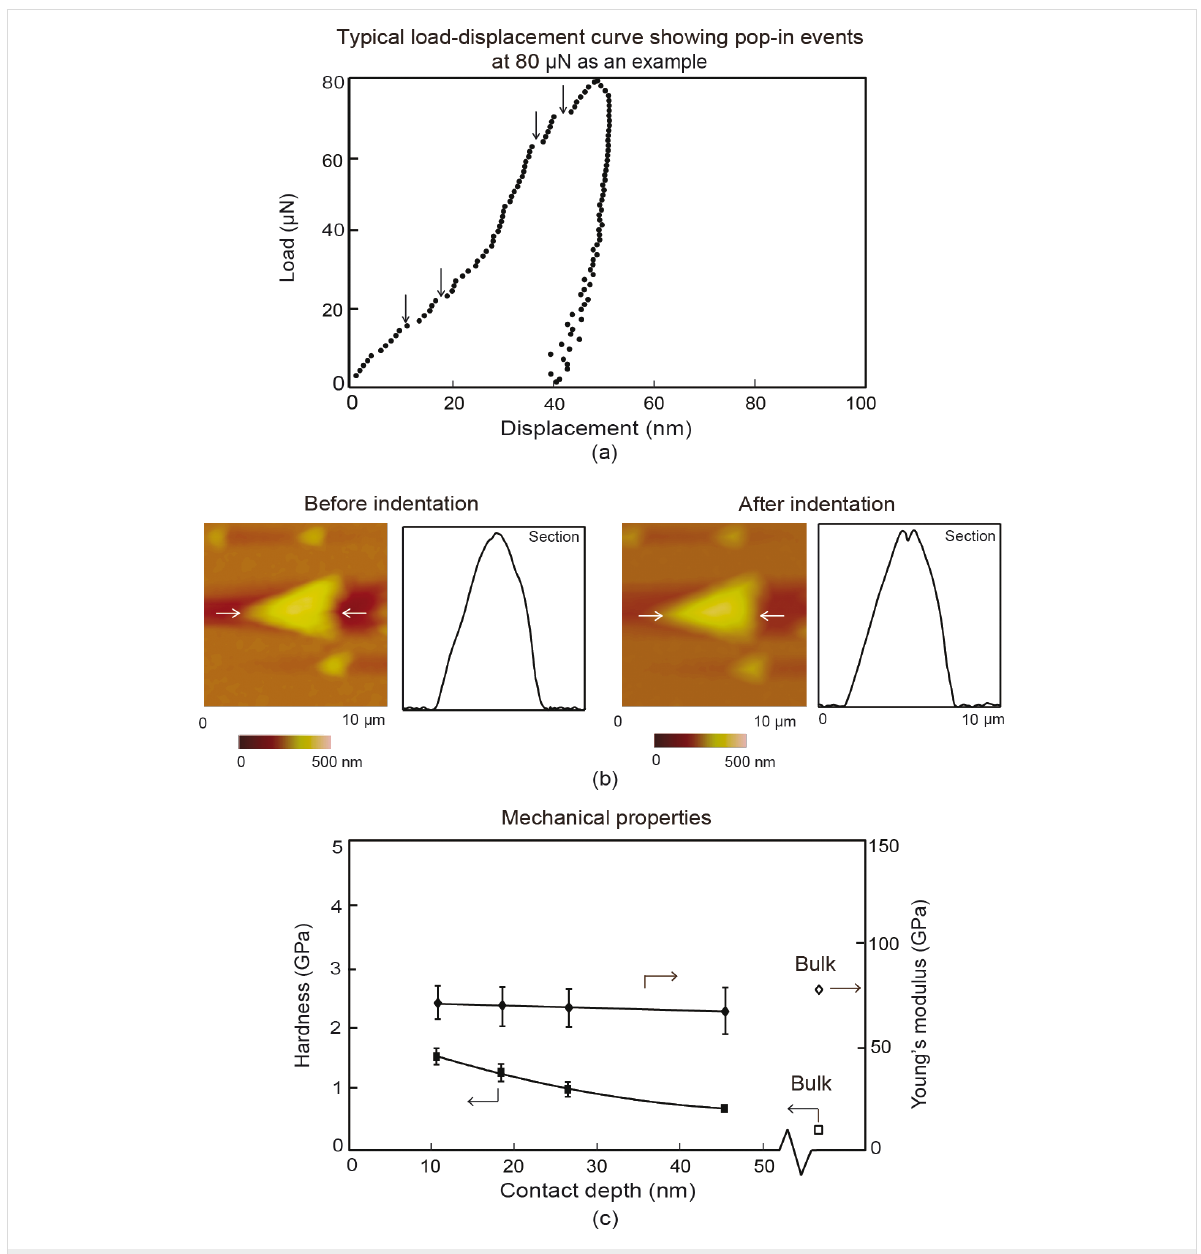
Figure 8: (a) Typical load displacement indentation curve at a maximum load of 80 µN with vertical arrows showing pop-in events and (b) topography maps and 2-D profiles at sections shown by the horizontal arrows before indentation and after indentation. (c) Mechanical properties of Au 500 nanoparticles with hardness and Young’s modulus as a function of contact depth represented by bold square and diamond datum points, respectively, with corresponding open diamond and square datum points representing bulk mechanical properties.